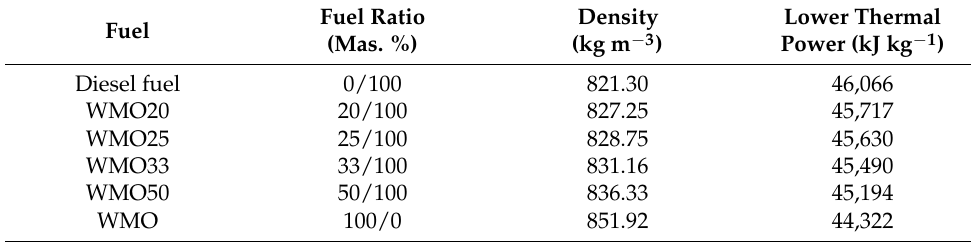
Table 2. Fuel properties of test